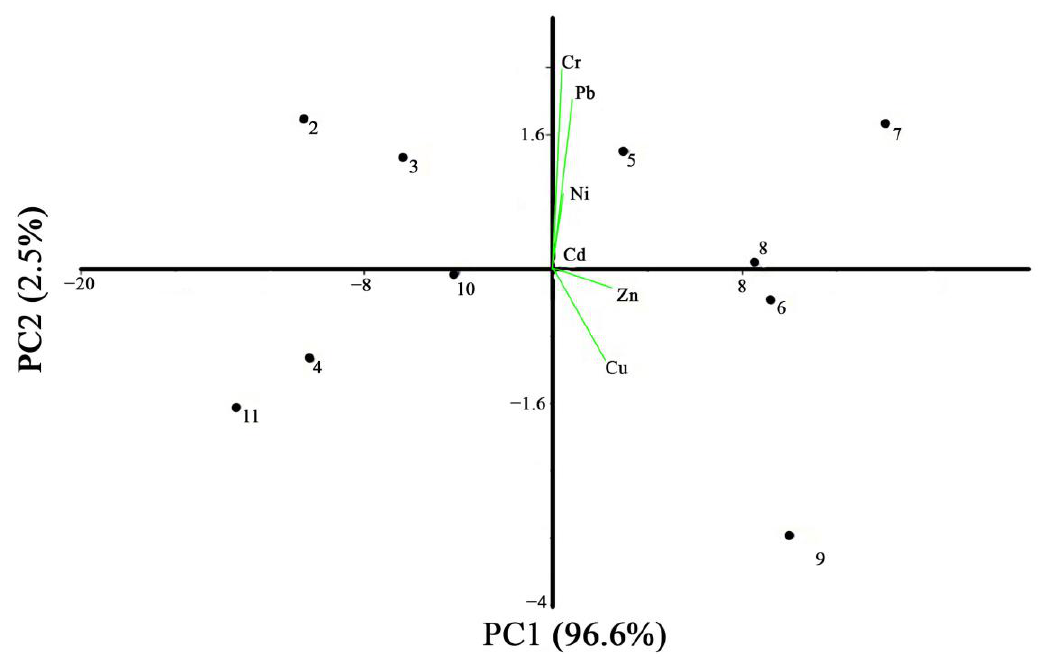
Figure 3. Principal component analysis (PCA) of studied trace metals from Collins Ice Cap.